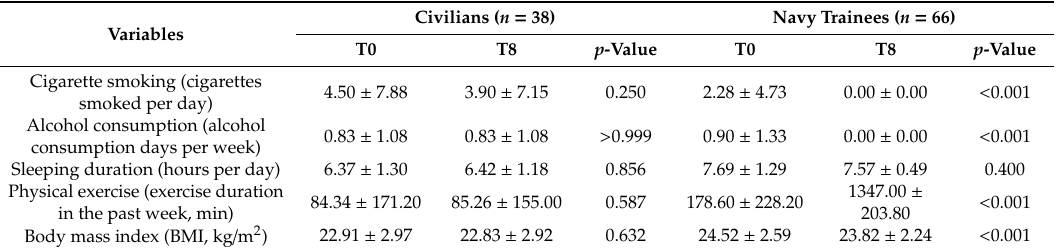
Table 2. Characteristics of participants at T0 and T8. Data are shown as mean ± SD; p -values are obtained by Wilcoxon matched-pairs signed-rank test.